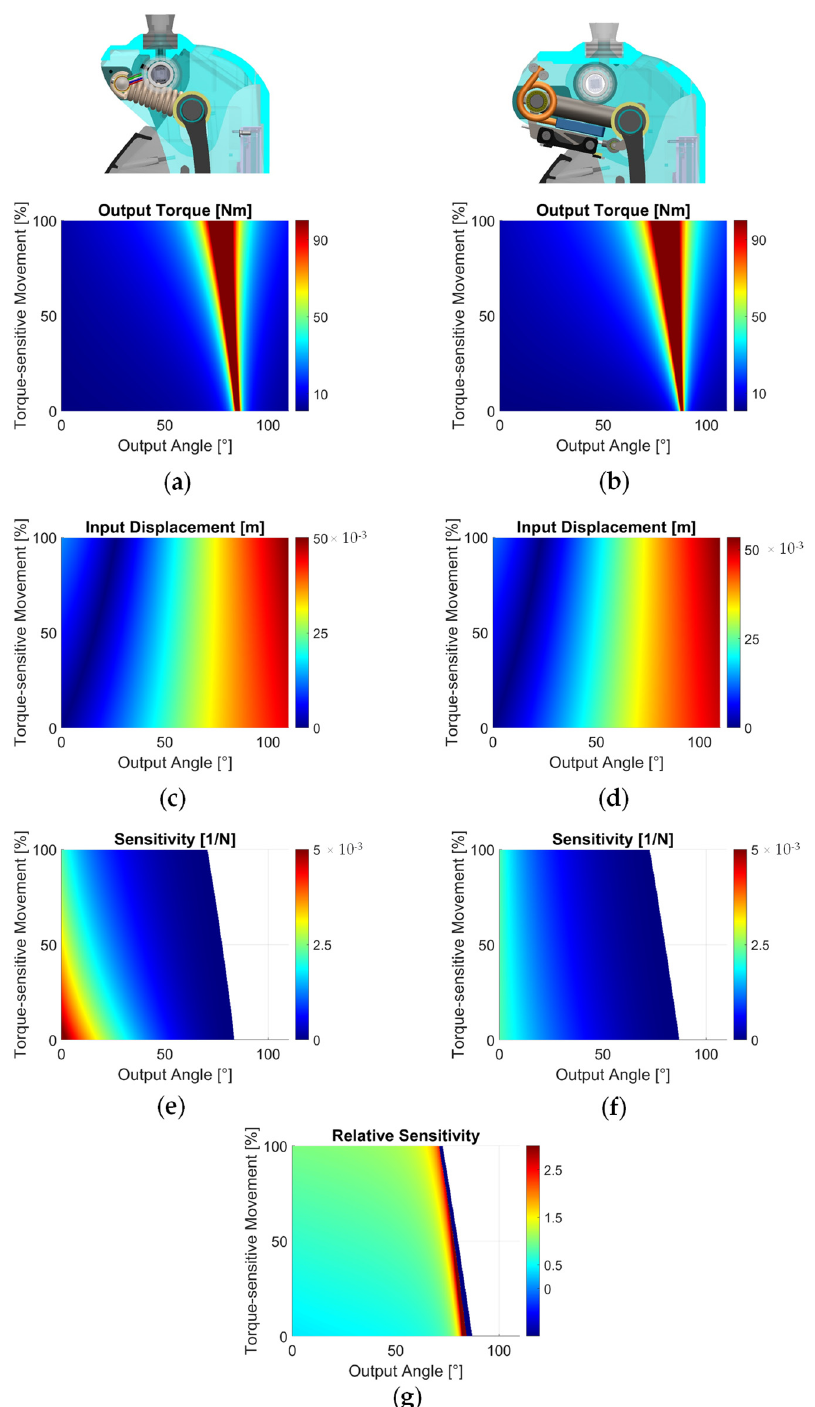
Figure 5. Calculated output torque and input displacement across the operation space. ( a ) Output torque heatmap of the linear implementation. ( b ) Output torque heatmap of the torsional imple- mentation. The value of output torque is capped at 100 Nm to allow for a meaningful visualization across the operation space. ( c ) Input displacement heatmap of the linear implementation. ( d ) Input displacement heatmap of the torsional implementation. Displacements shown in Figure 5 c , d are relative values with respect to the neutral position (i.e., 0 ◦ output angle and 0% spring extension) of each implementation. Calculated sensitivity across the operation space. ( e ) Sensitivity heatmap of the linear implementation. ( f ) Sensitivity heatmap of the torsional implementation. ( g ) Relative sensitivity of the torsional implementation with respect to the linear